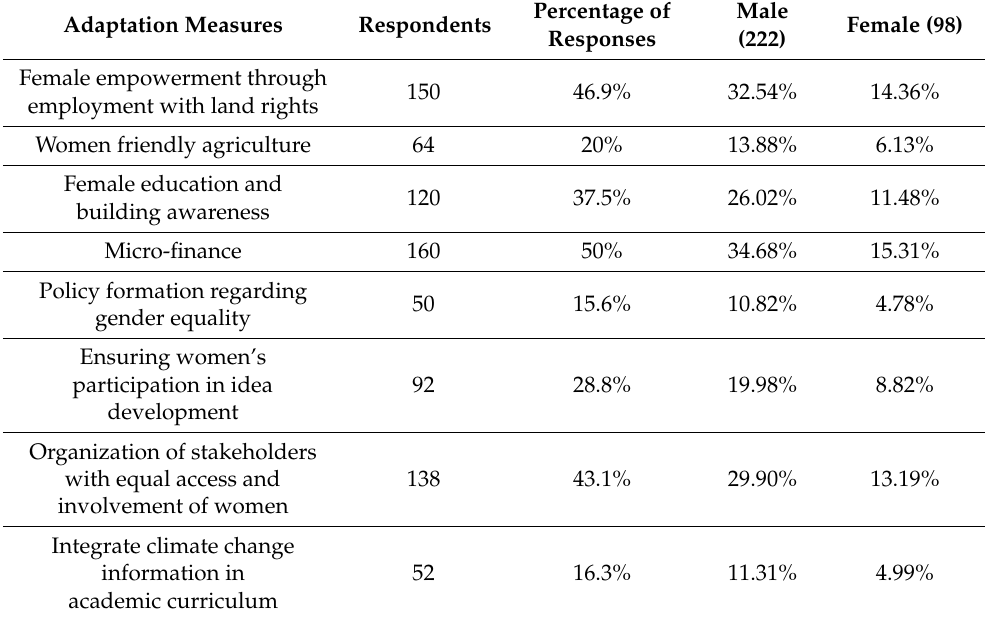
Table 7. represents women-centered adaptation measures in the